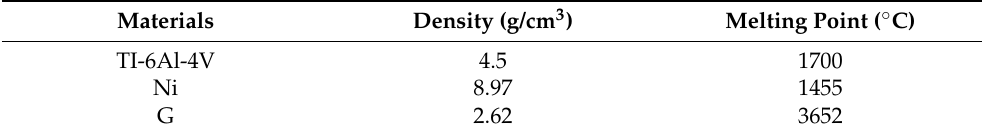
Table 1. Properties of Ti-6Al-4V alloy and nickel-coated graphite.